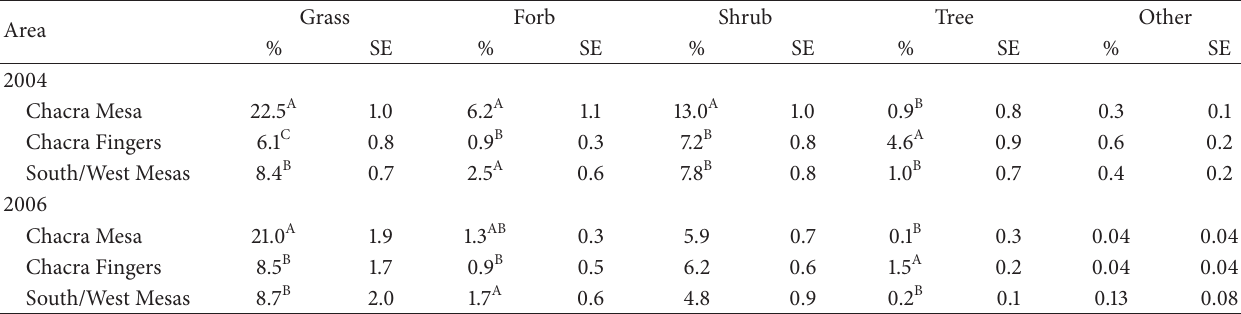
Table 4: Mean percent of total plant cover comprised of grasses, forbs, shrubs, trees, and other (i.e., succulents, etc.) classes of plants in use (Chacra Mesa, Chacra Fingers) and control (South/West Mesas) areas, Chaco Culture National Historical Park, August-September 2004 and 2006. Grass Forb Shrub Tree Other Area